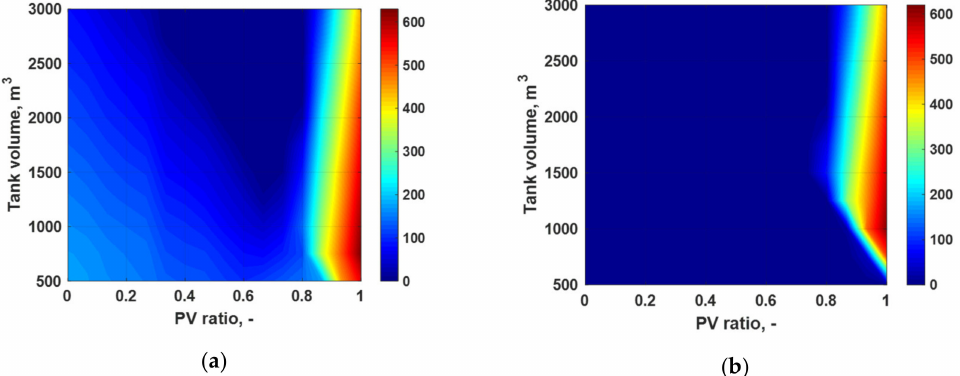
Figure 16. Variation of battery parameters for different water tank volumes and PV ratios for Svishtov (wine grapes), with a 15 kW HRES, with mSi PV panels and WT type 3: ( a ) the maximal achieved capacity during the irrigation period (kWh); ( b ) the final state of the charge in the end of the irrigation period